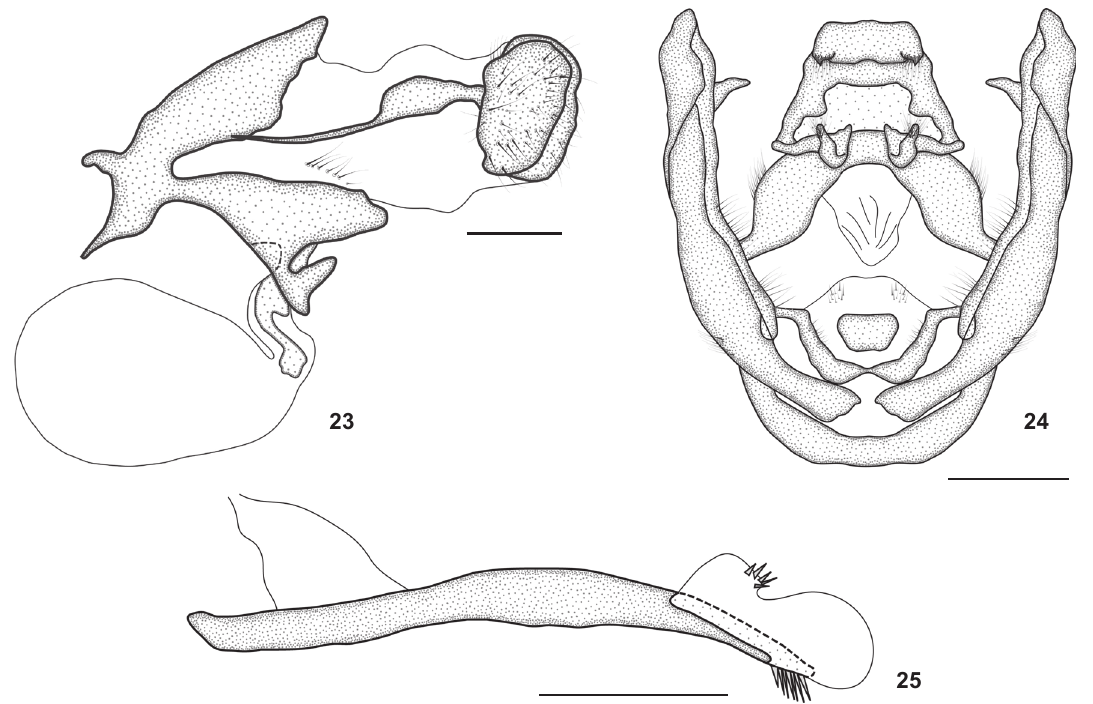
Figures 23-25. Female and male genitalia of L. dentilinea : (23) female, lateral view; (24-25) male: (24) genital capsule, posterior view; (25) aedeagus, lateral view. Scale bar: 1